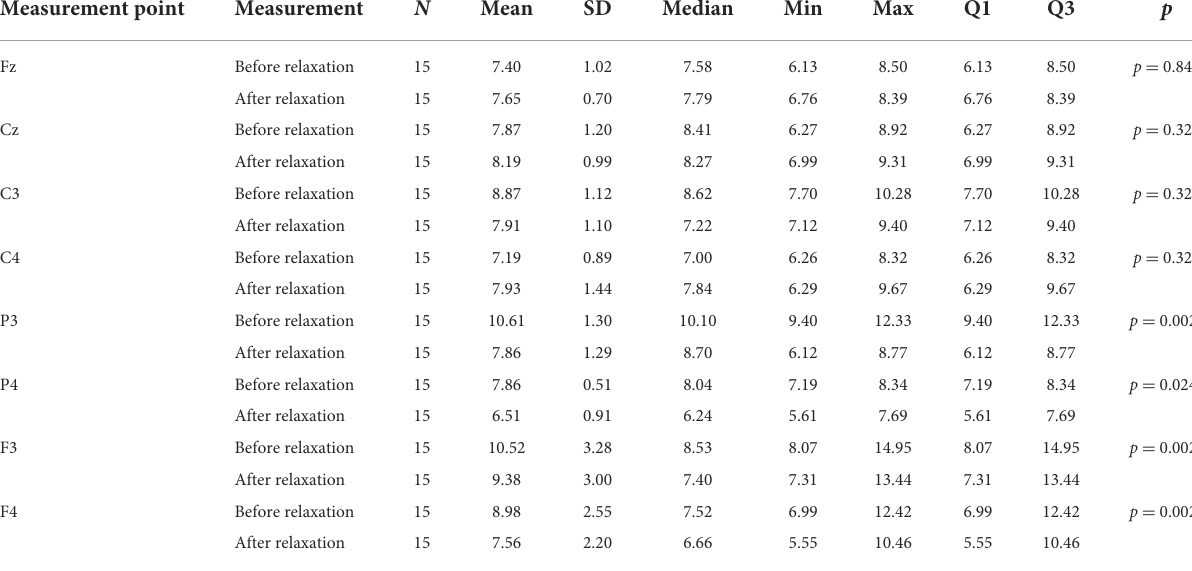
TABLE 5 Comparison of Beta 2 wave amplitudes before the SKY course (first day) and after the whole SKY course (third day) with eyes open. Measurement